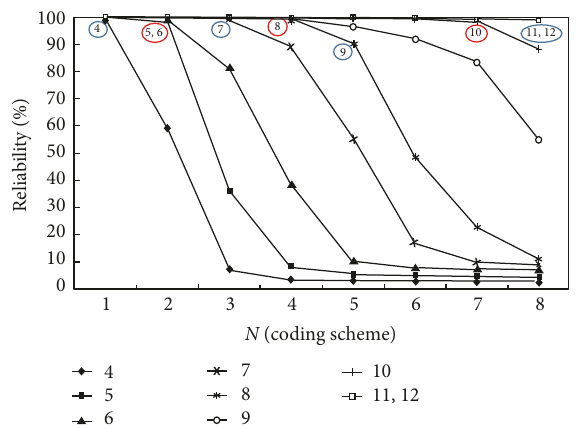
Figure 2: Reliability of different coding schemes versus network density